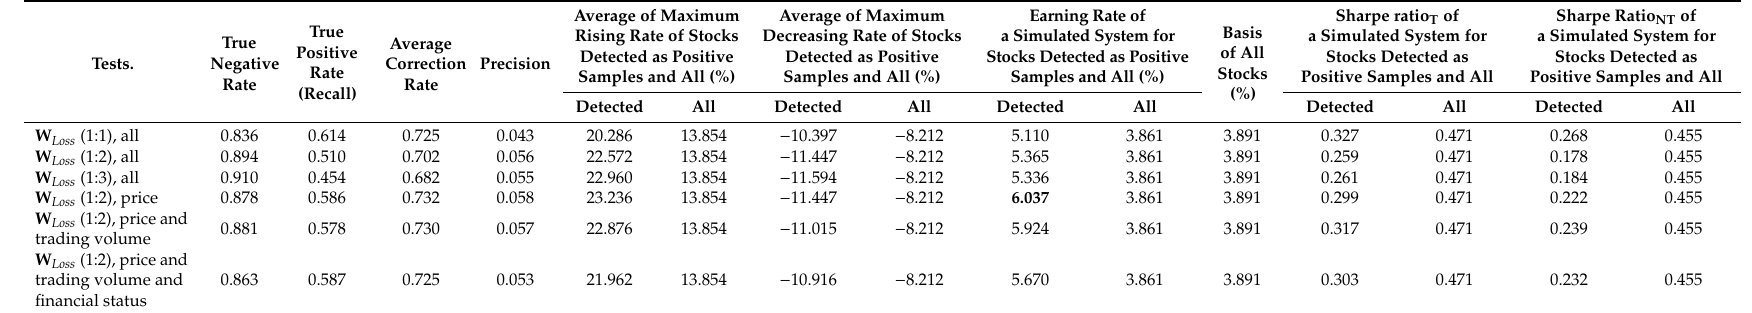
Table 5. Constant threshold-based stock classification with di ff erent W Loss values and di ff erent features (all: all features; price: price-related features; trading volume: trading volume feature; financial status: company financial status-related features).